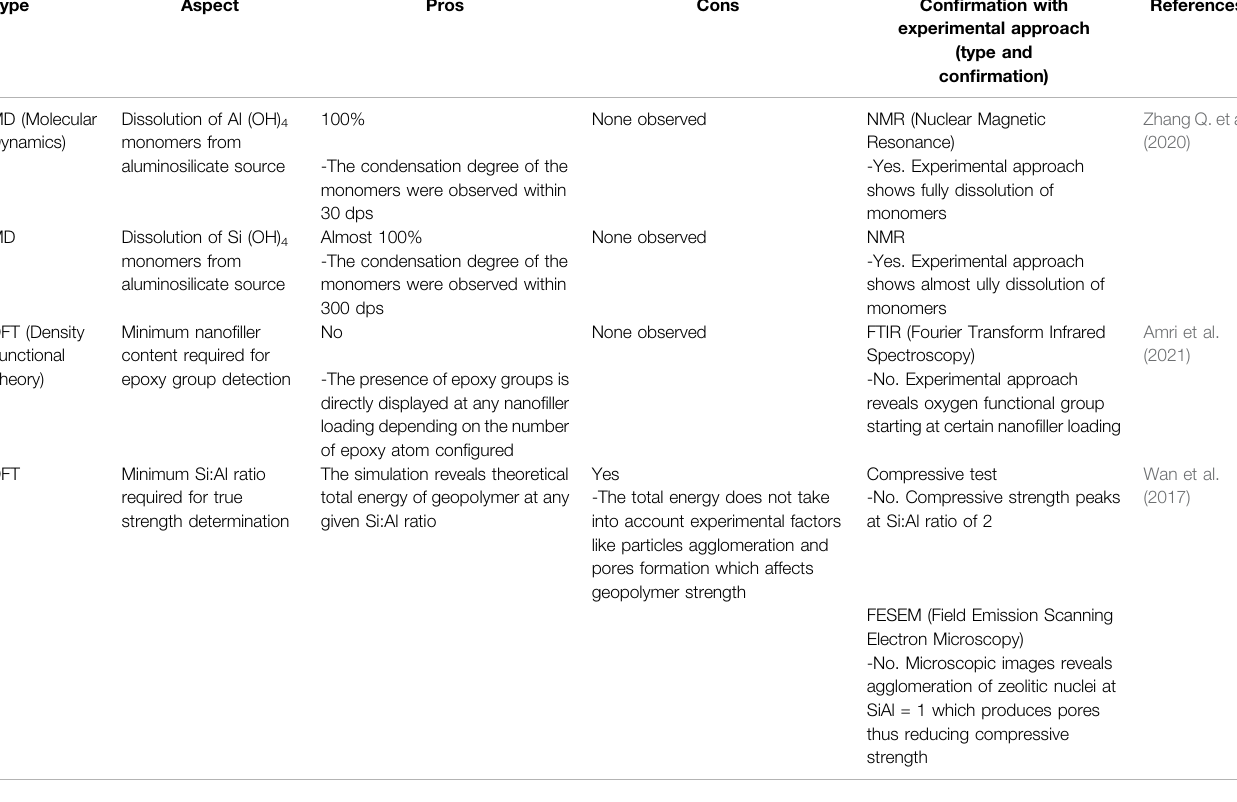
TABLE 6 | Pros and cons of analytical modeling in geopolymer.